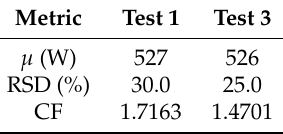
Table 3. Mean, RSD and CF of the power output time series: test 1 and test